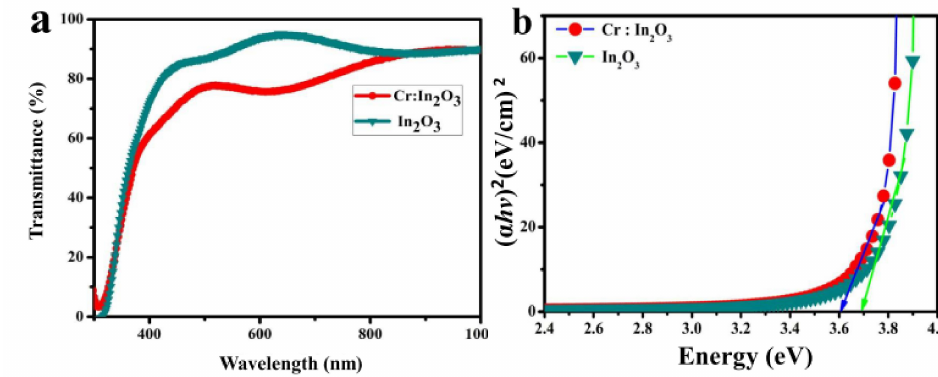
Figure 3. ( a ) Optical transmittance and ( b ) bandgap spectra of pure and Cr doped In 2 O 3 films. Optical bandgap of pure In 2 O 3 and Cr doped In 2 O 3 thin films are assumed from the plot of ( α h υ ) 2 vs. h υ , as given in Figure 3b. The direct bandgap ( E g ) values of pure and Cr